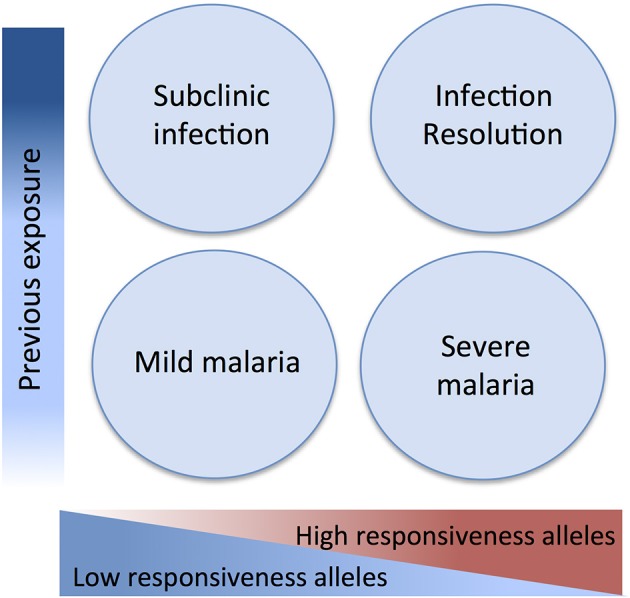
Genetic variants in inflammatory response genes and infection outcomes. Genetic variants controlling inflammatory responsiveness are proposed determinants of malaria clinical outcomes dependent on history of exposure to infection. Under the framework of a polygenic model of malaria susceptibility the additive effects of genetic variants conferring strong inflammatory responsiveness to infection concur to severe disease but may favor efficiency of anti-parasite responses in repeatedly exposed individuals. On the other hand, joint effects of alleles conferring low inflammatory responsiveness results in increased resilience to severe malaria but are associated to asymptomatic parasitemia in exposed individuals possibly due to inefficient parasite clearance.